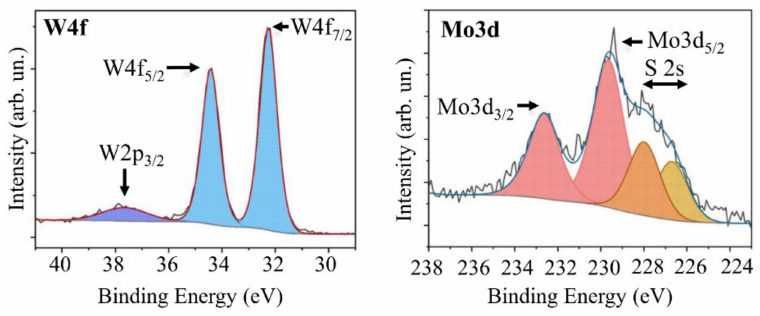
Figure 15. XPS W4f and Mo3d (overlapped with S2s) spectra for a very thin MoS x film obtained by on-axis reactive PLD on the surface of WSe 2